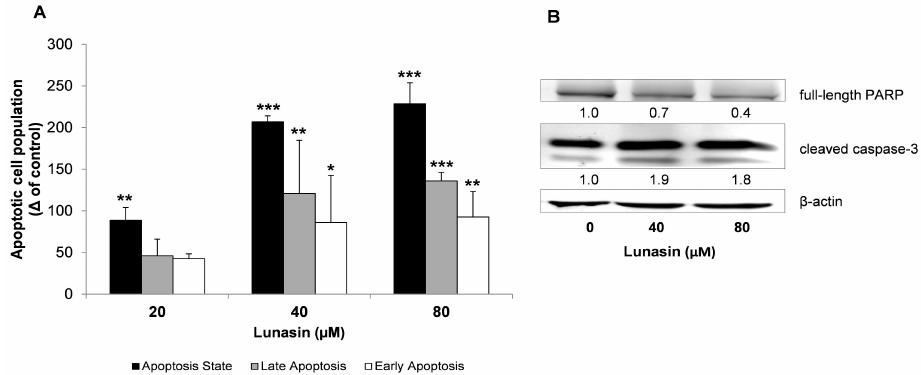
Figure 2. E ff ect of lunasin on the apoptosis state of HCT-116 cells. Cells were treated with lunasin at the indicated concentrations (20, 40, and 80 µ M) for 72 h, and harvested for apoptosis analysis and Western immunoblotting. ( A ) Flow cytometry-based Annexin V / PI double labeling of apoptotic cells. Total apoptotic cells were identified as Annexin V-positive cells (apoptosis state), being Annexin V-positive / PI-negative and Annexin V-positive / PI-positive cells identified as early apoptotic and late apoptotic cells, respectively. Results, presented as the increased number in apoptotic cell populations compared to control cells, are means ± standard deviation (SD) of the replicates of experiments carried out. * ( p < 0.05), ** ( p < 0.01), *** ( p < 0.001) significantly di ff erent from control. ( B ) Expression of full length PARP and cleaved caspase-3 proteins determined by Western Blot. The numbers underneath the blots represent band intensity that was normalized to β -actin and measured by Image J software (means of duplicates, and standard deviations within ± 15% of the means were not shown). β -actin was served as an equal loading control for cytosolic